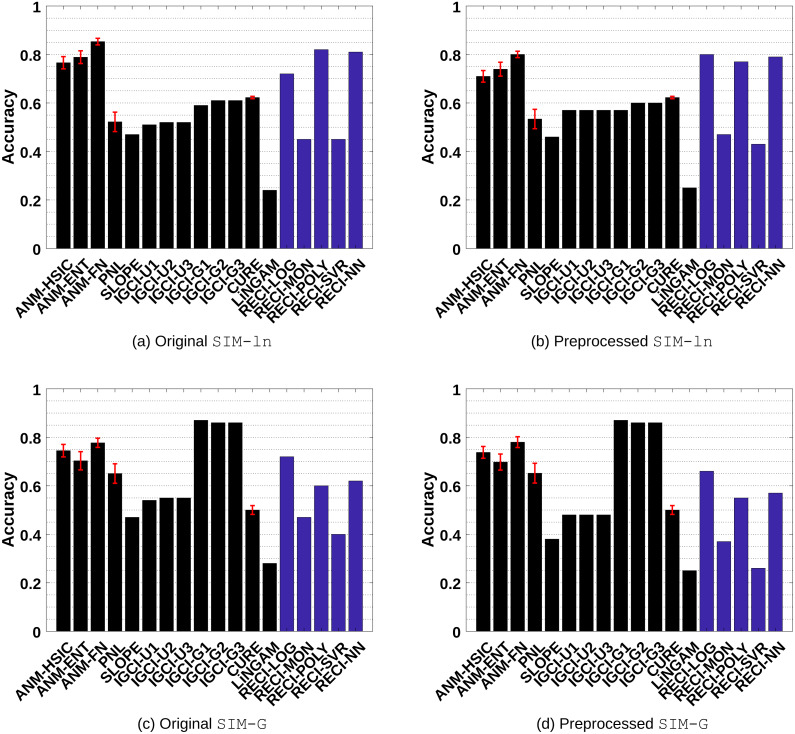
Evaluation results of all methods in the SIM-ln and SIM-G data sets.(A) and (C) show the results of the evaluations in the original data and (B) and (D) the results in the preprocessed versions where low-density points were removed.